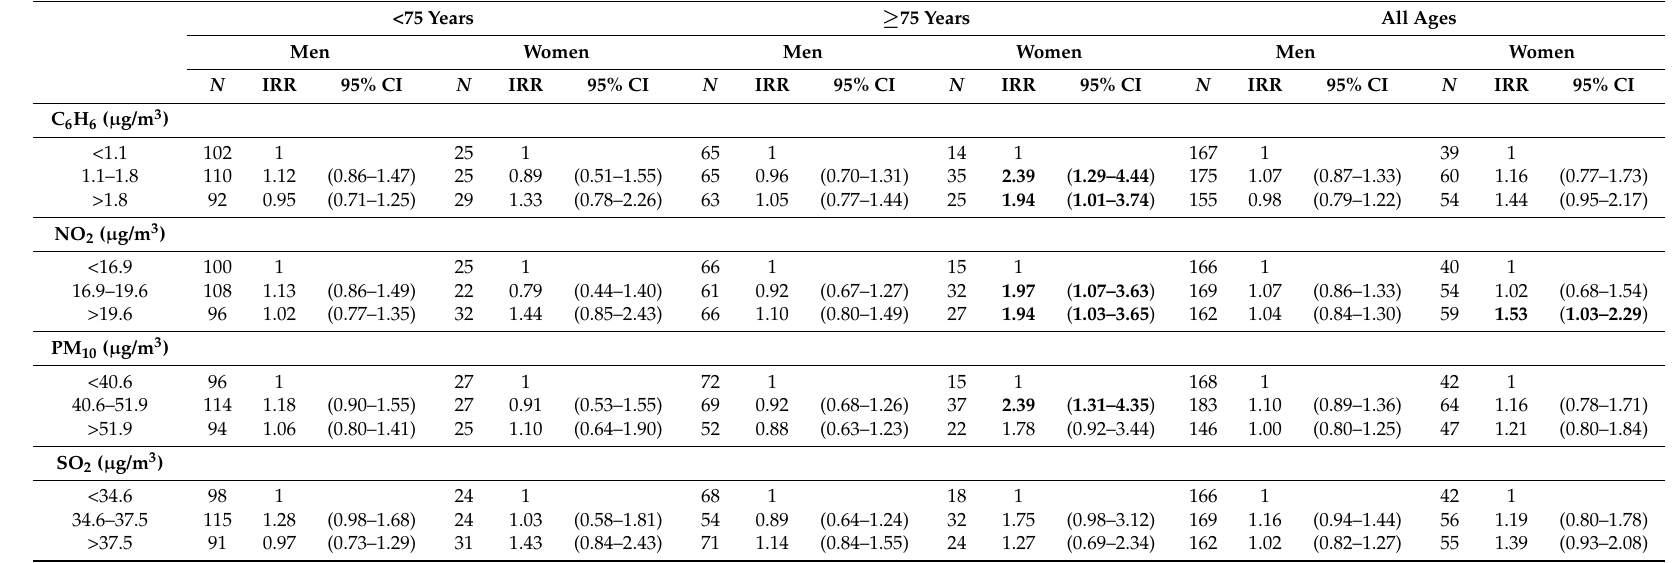
Table 3. Number of incident cases of bladder cancer incidence rate ratio (IRR) with corresponding 95% confidence intervals (CI), by sex, tertile of exposure, and age group. 1995–2009 in 14 municipalities. Statistically significant results are reported in